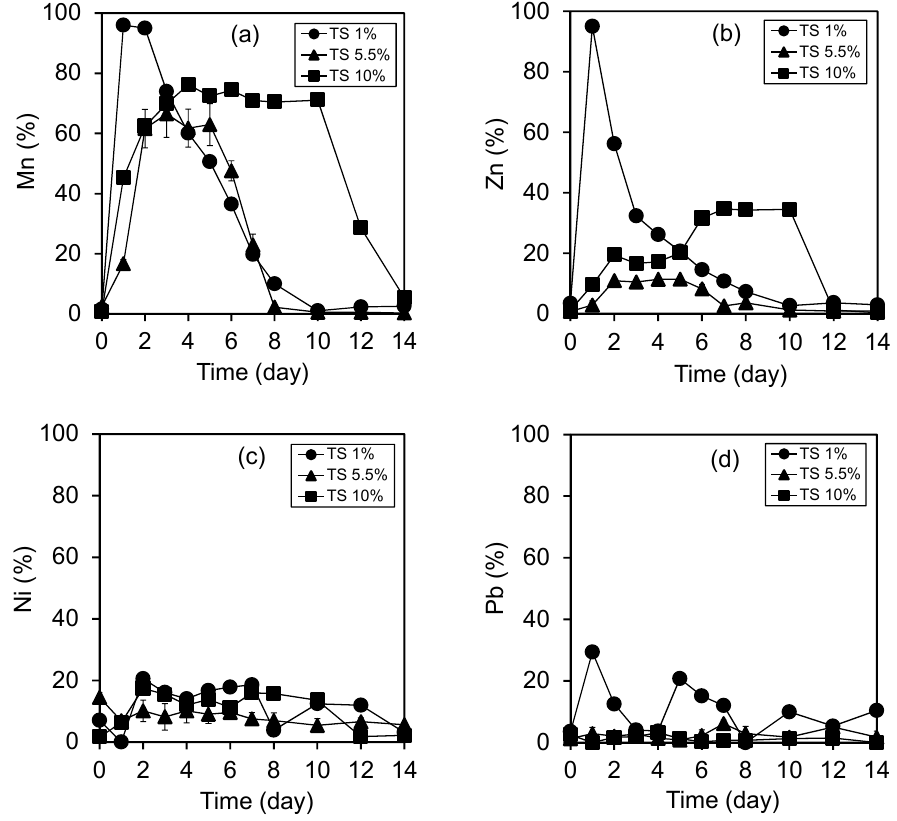
Figure 3. Effects of sludge solid content on the metal solubilization during the fungal bioleaching experiments ( a ) Mn, ( b ) Zn, ( c ) Ni and ( d ) Pb.